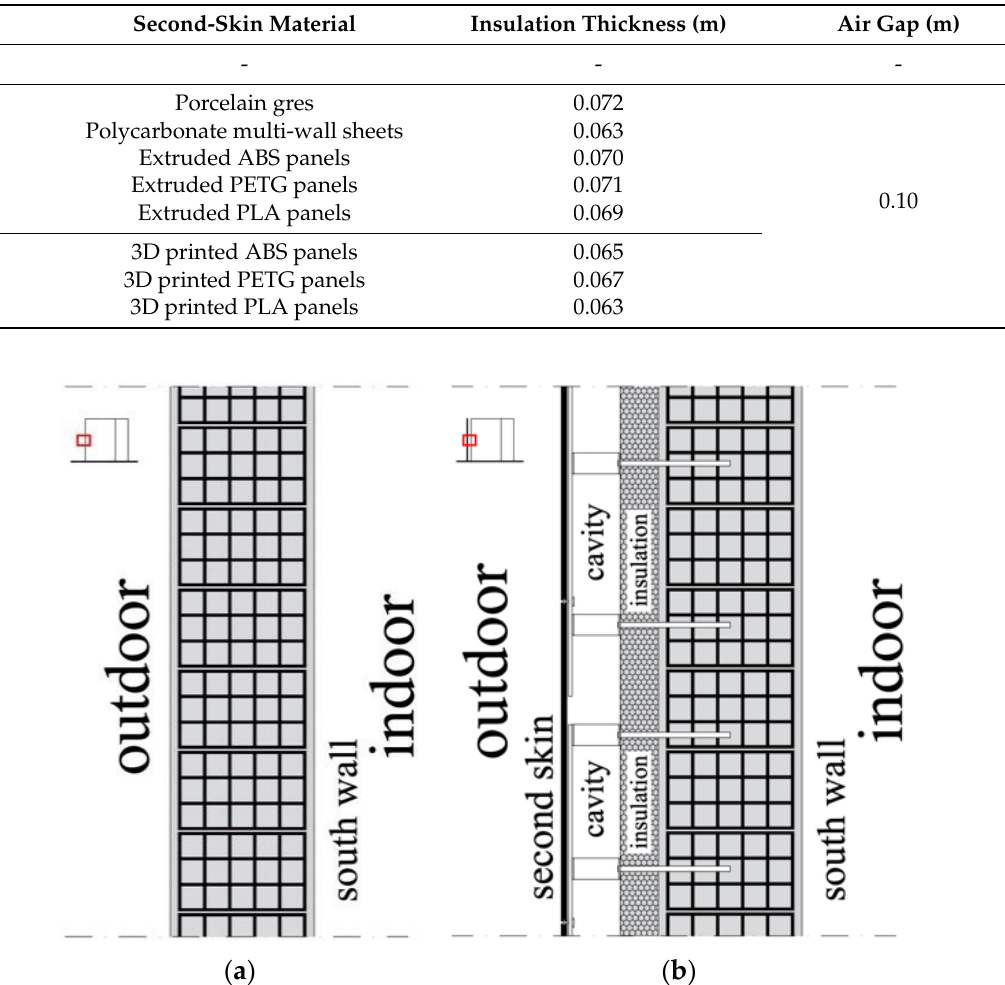
Table 3. Summary of case studies investigated.